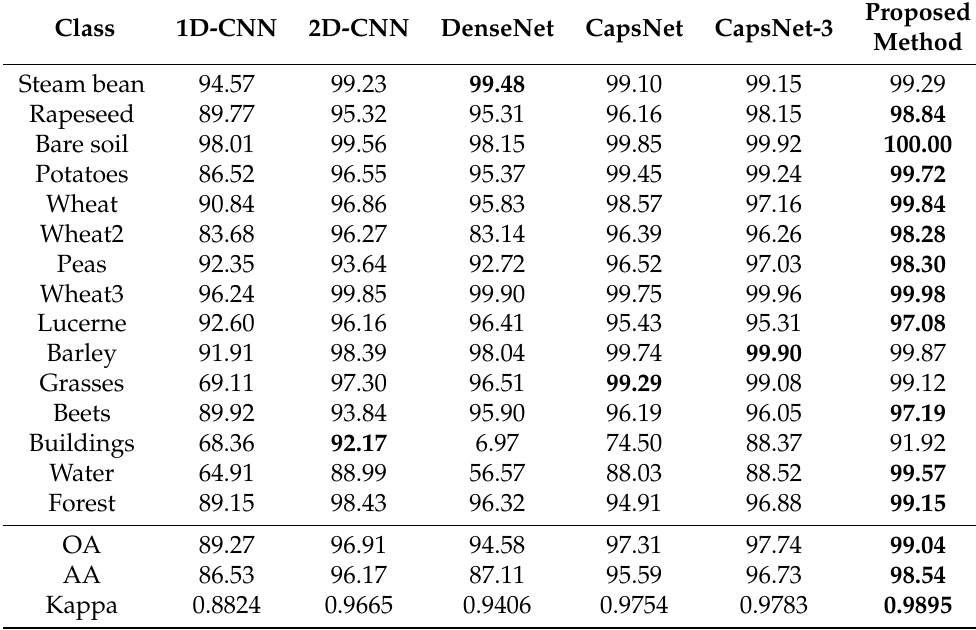
Table 6. Classification Accuracy (%) of the AIRSAR Flevoland Dataset.